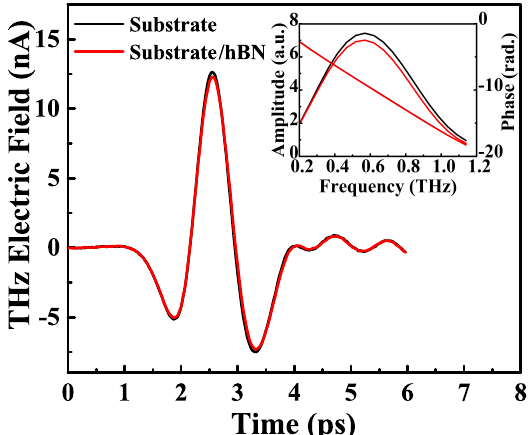
Figure 1. The THz electric field strength transmitted through ML hBN on the quartz substrate (red curve) and through the bare quartz substrate (black curve), respectively, as a function of delay time at T = 280 K. The inset shows the corresponding amplitudes and phase angles of the THz electric field strengths transmitted through the ML hBN sample and the substrate in the frequency domain. The results for the phase angles coincide roughly.